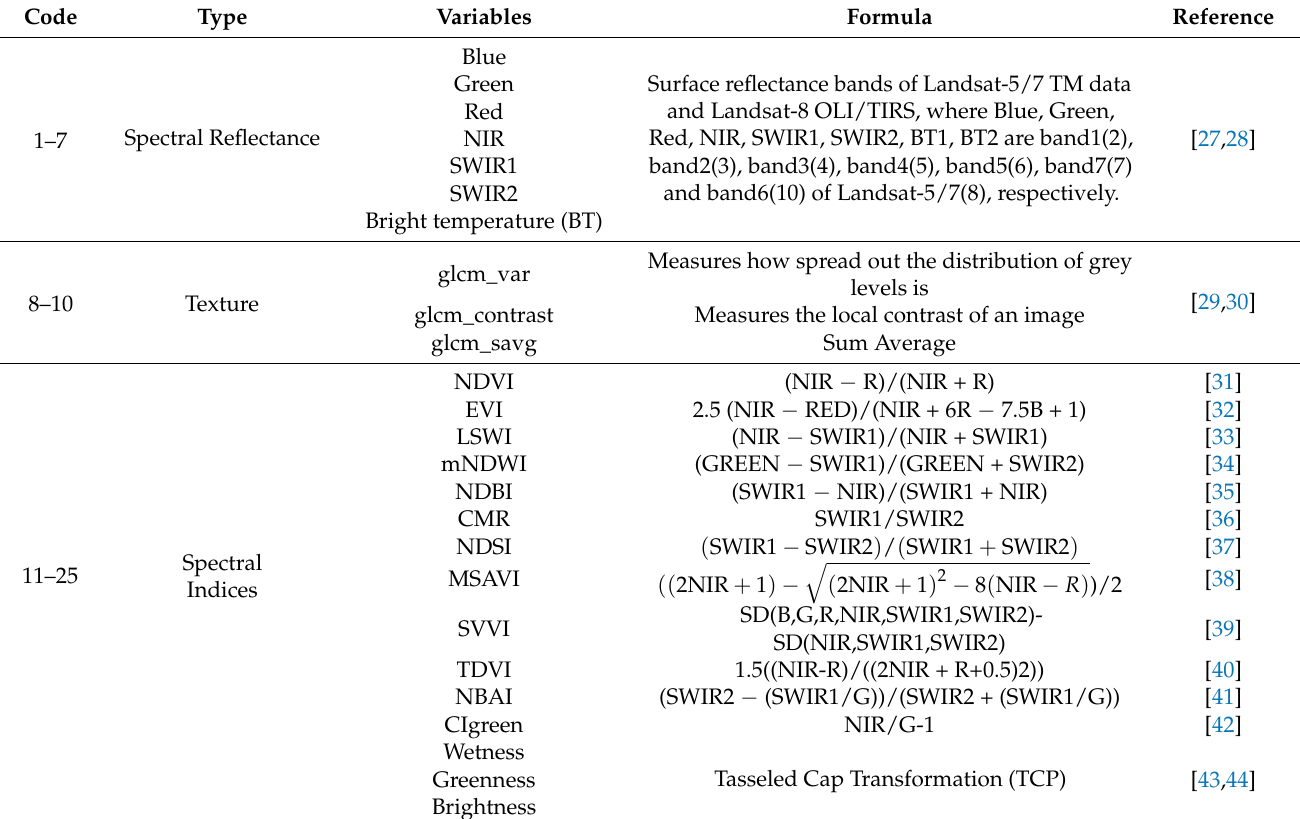
Table 2. Description of spectral, texture and seasonal variables and relevant